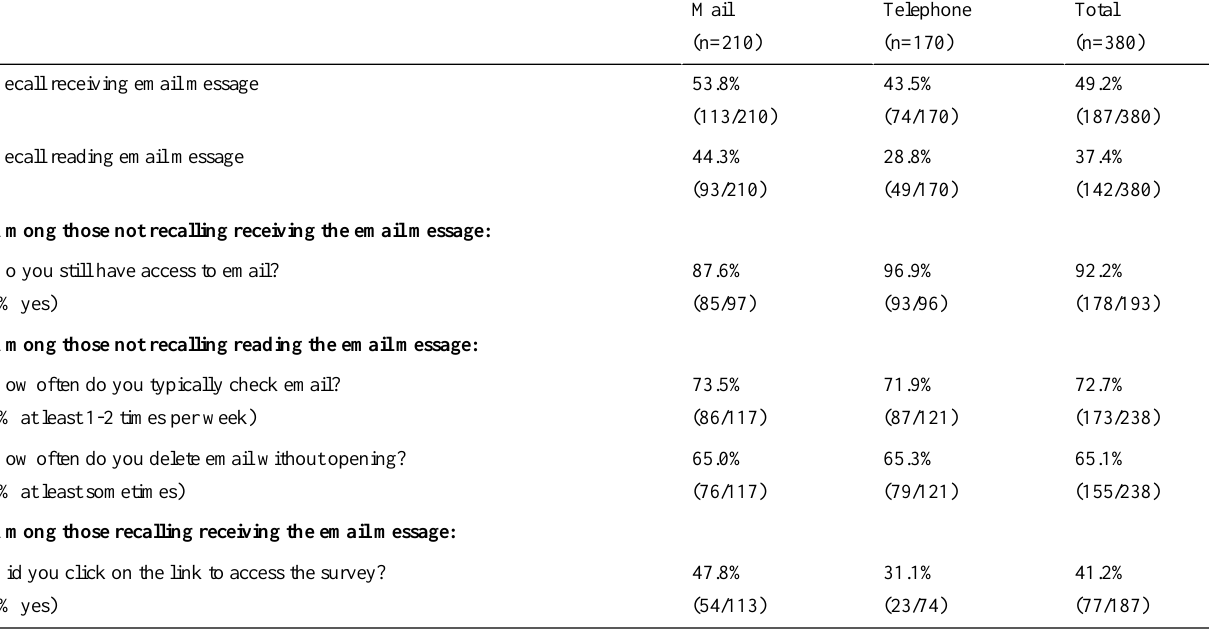
Table 2. Responses to nonresponse follow-up questions about the email